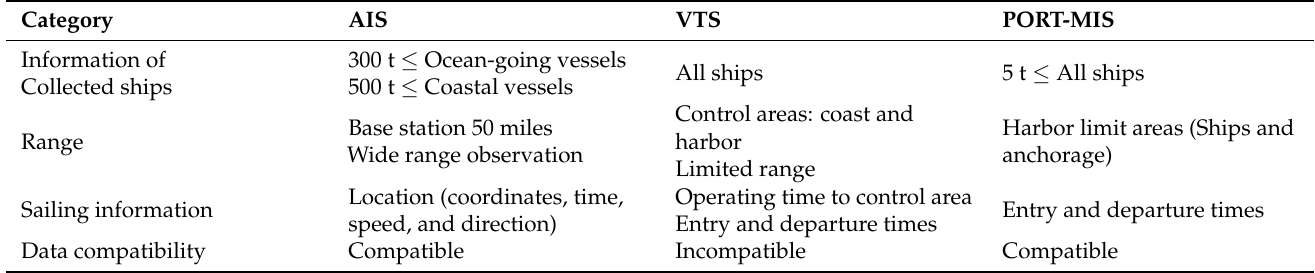
Table 1. Comparison of operation information systems of Automatic Identification System (AIS), Vessel Traffic Service System (VTS), and PORT-management information system